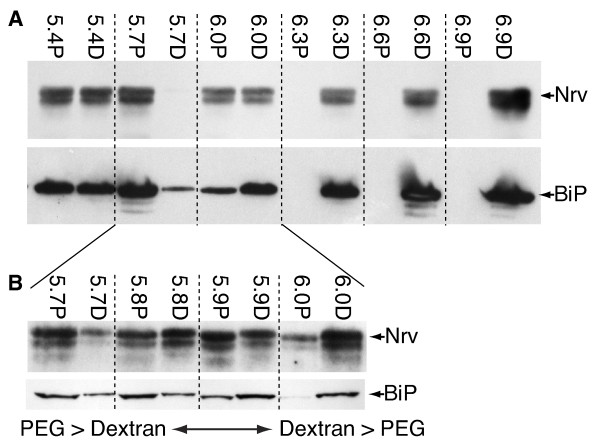
Optimization of PEG/Dextran concentrations to be used for two phase affinity partitioning. A. Immunoblot analysis of partitioning of Nervana and BiP into PEG (P) and Dextran (D) at different concentrations of PEG/Dextran (from 5.4% PEG/Dextran to 6.9% PEG/Dextran). At concentrations above 6.0-6.3% Nervana partitions into the dextran phase preferentially while at 6.0% and below Nervana is found in both phases. BiP behaves identically. The significant drop in microsome partitioning into dextran seen between 5.7% and 6.3% is seen in all preparations but can be variable in extent, as illustrated in B. B. The same experiment performed for a range of percentages from 5.7-6.0% PEG/Dextran reveals a fairly abrupt transition between 5.8% and 5.9%. While a majority of both markers is seen in the PEG fraction at 5.7% and in the Dextran phase at ≥ 6.3%, the precise fractionation behaviour in the transition zone is somewhat variable. The Nrv and BiP blots shown in this panel are from different preparations to illustrate this phenomenon (see text for further discussion).